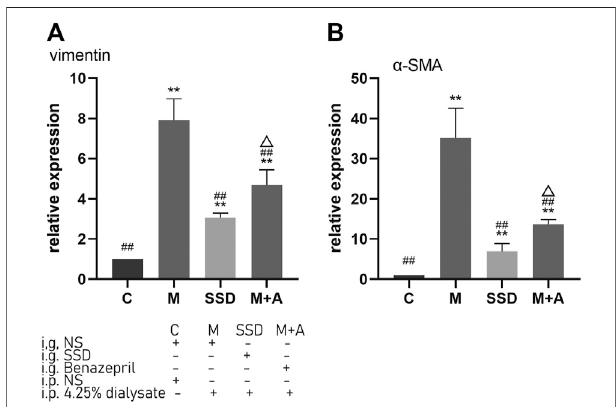
FIGURE6| Expressionlevelsofvimentin and α -SMAofperitonealtissue by PCR. Data are presented as mean ± SD ( n (cid:2) 3). For comparison with the group M, ## indicates p < 0.01; for comparison with the C group, ** indicates p < 0.01; for comparison with the group M, ## indicates p < 0.01; for comparison with the SSD group, △ indicates p <